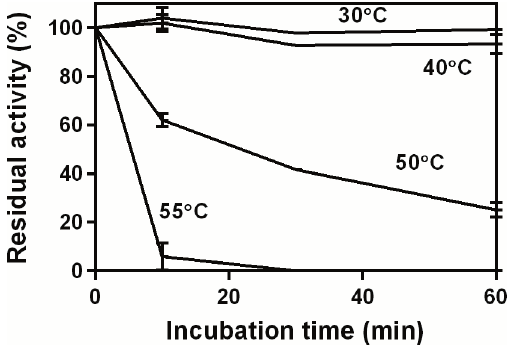
Figure 4. Residual activity curves for the extract incubated over 60 min at different temperatures. The pectinase complex produced by Aspergillus niger CH4 in solid-state fermentation was used. Residual activities were obtained at 50 u C, in a 10-min assay, using 0.5% pectin (w/v).